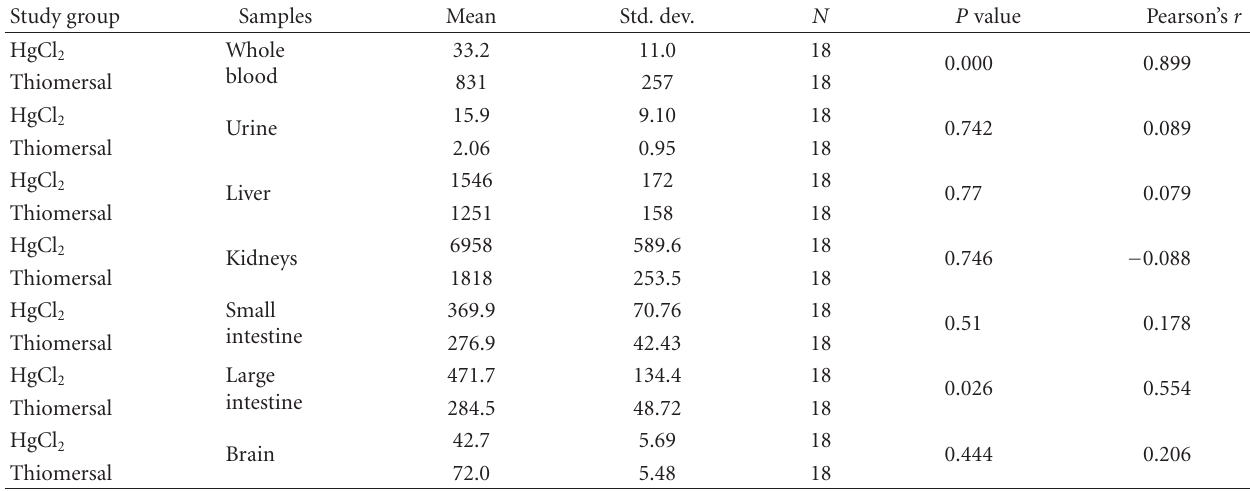
Table 2: Descriptive characteristics and Pearson’s correlation coe ffi cient between two experimental groups of suckling rats exposed to HgCl 2 (mercuric chloride) or thiomersal (ethylmercury). Total mercury was measured in whole blood, urine, and tissues (liver, kidneys, small intestine, large intestine, and brain). Values are presented as µ g/L in whole blood and urine, and as µ g/g w.w. in the liver, kidneys, small intestine, large intestine, and